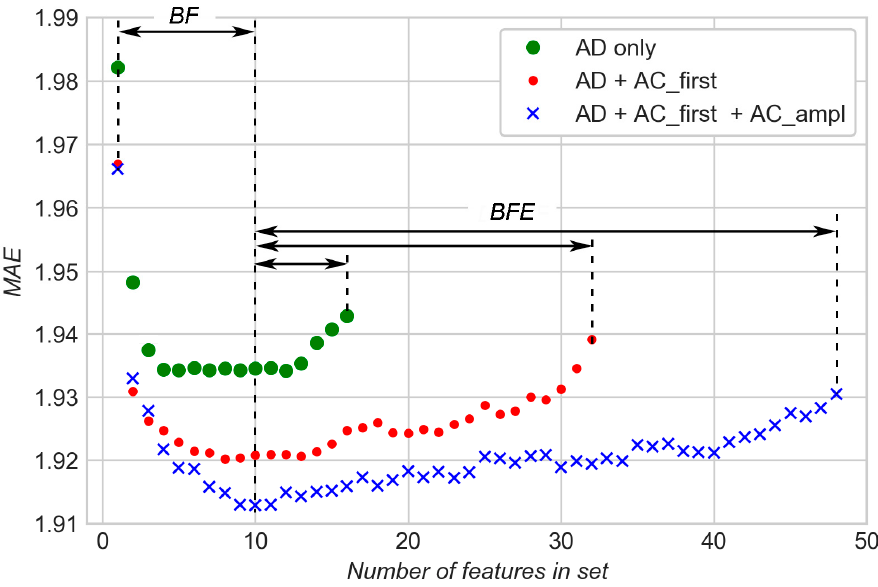
Figure 9. Comparison of modelling results for a different combination of features.